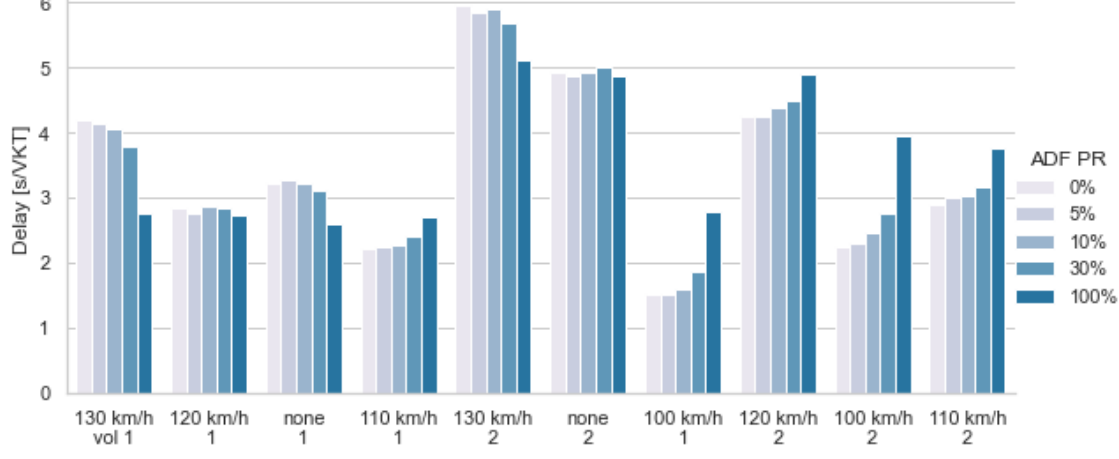
Figure 7. Average delay in seconds per VKT for the most common combinations of speed limit and traffic volume class (indicated below bars) by penetration rate among passenger cars on EU27+3 motorways. Volume class 1: up to 750 veh/h/lane; 2: 751–1250